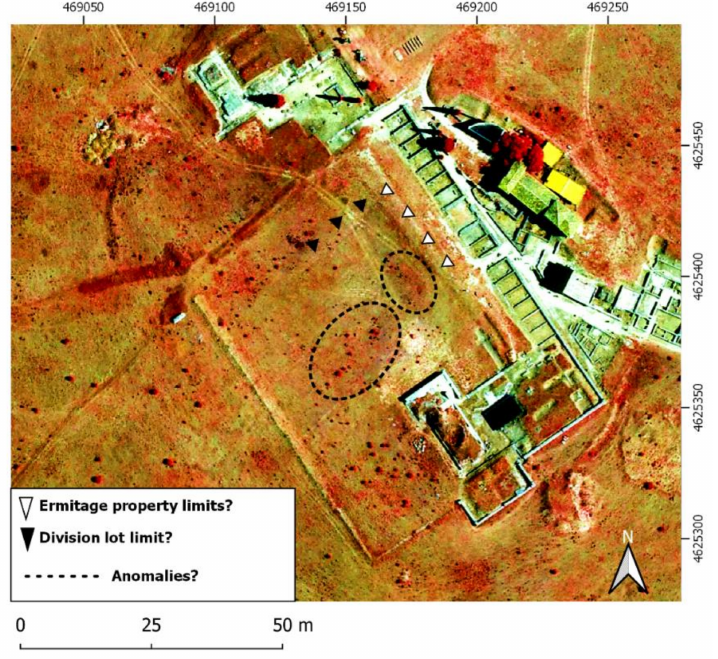
Figure 6. PNOA 2009, 25 cm. Bands